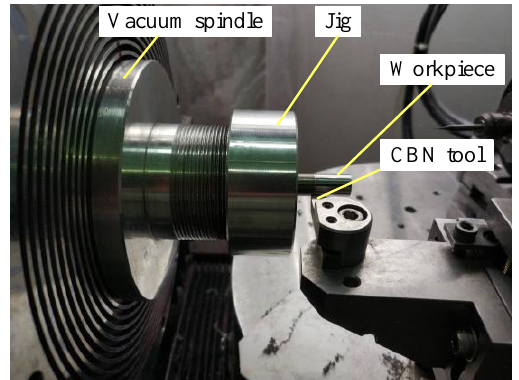
Figure 5. Experimental setup of the machining center.